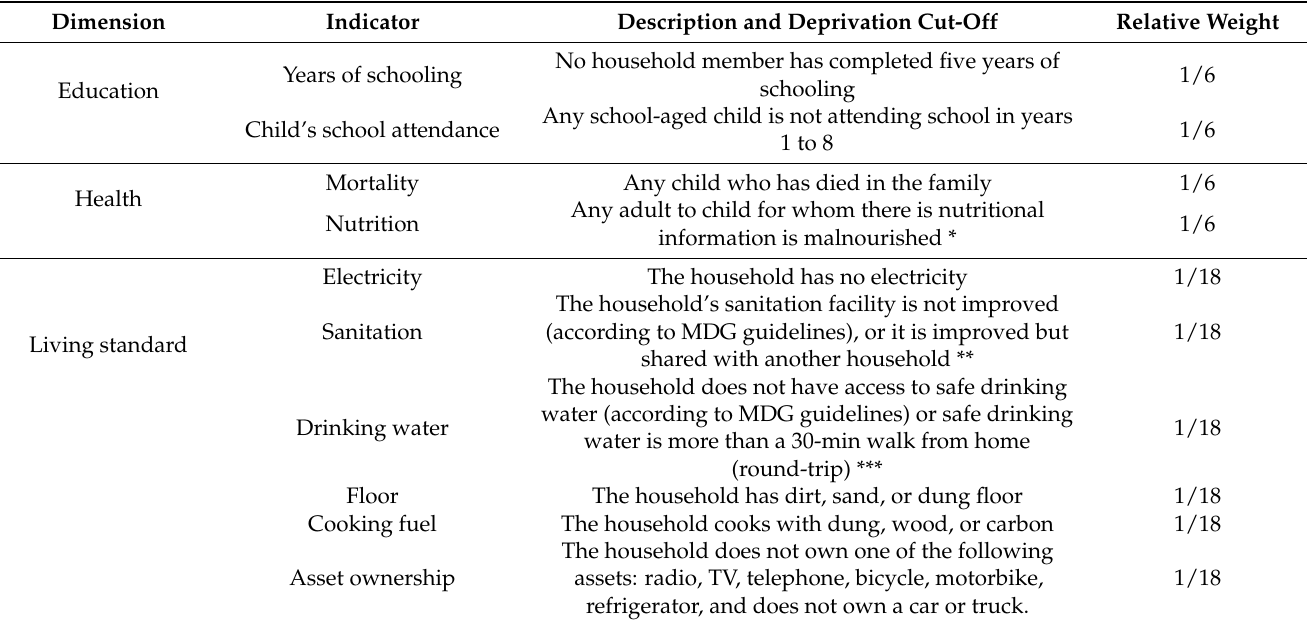
Table 1. Dimensions, indicators, deprivation cut-off, and weights of the multidimensional poverty index.